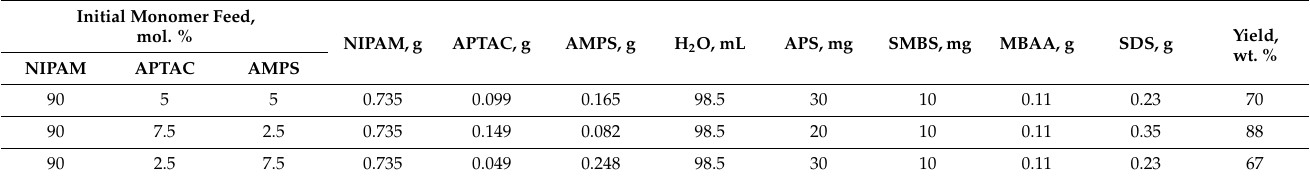
Table 1. Ratios of NIPAM-APTAC-AMPS